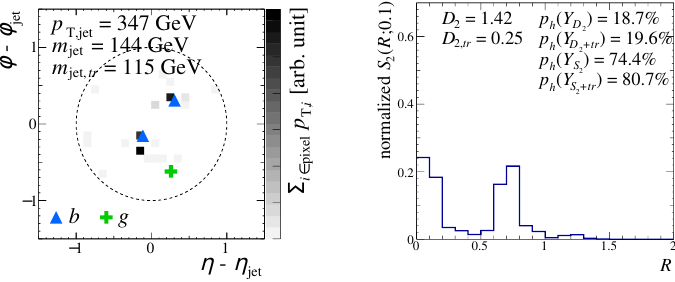
Figure 9 . The pixelated jet image (left), and two-point spectrum S 2 ( R ; 0 : 1) (right) of a Higgs jet. The event is Higgs-like in the neural networks with S 2 ( R ), N S and N S , but it is not in 2 2 + tr those with D 2 , N D and N D . The sum of the bins of the spectrum is normalized to 1. The 2 2 + tr blue triangles and green plus symbols in the pixelated jet images indicate direction of b quarks and gluons obtained from the matrix element including order (cid:11) S radiations. We show the Higgs-like probability p h ( Y X ) in an ANN model N X de(cid:12)ned by eq. (4.7).